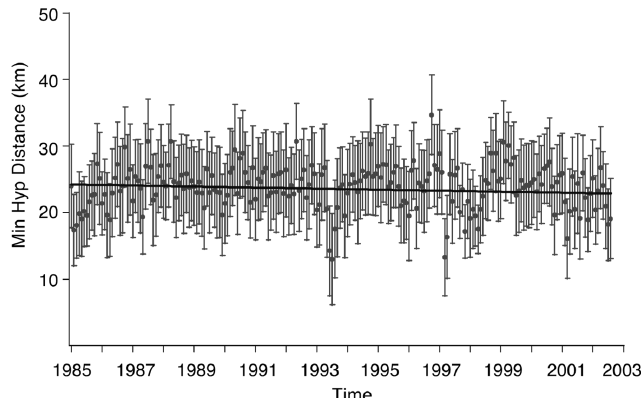
Fig. 2. Monthly averages (dots) of minimum hypocentral distance and associated standard deviation (bars) from year 1985 to August 2002. Only events with minimum distance less than 50 km contributed to the aver- age. The line represents the linear fit of the minimum distance versus